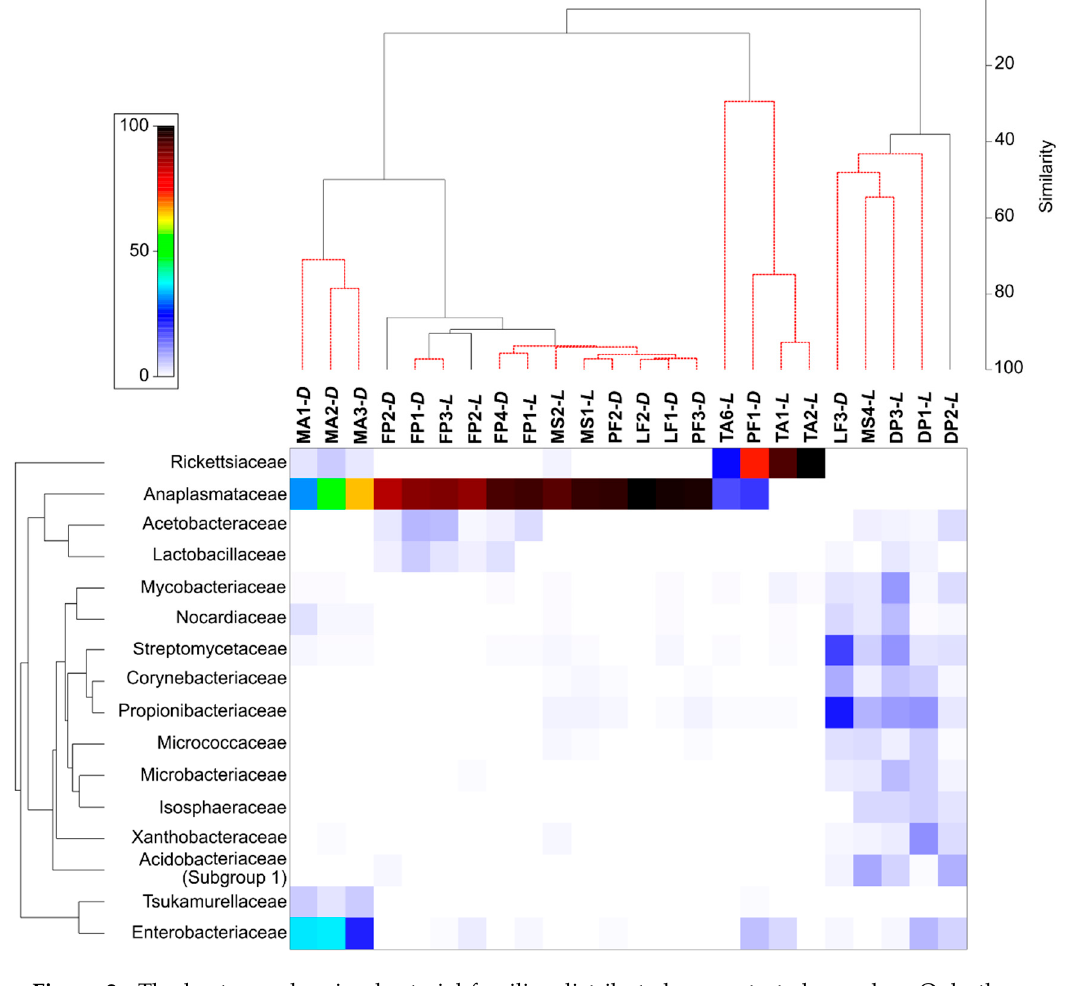
Figure 2. The heatmap showing bacterial families distributed across tested samples. Only those families who were primarily responsible for the observed differences among samples were considered. Both dendrograms were estimated with the Bray–Curtis dissimilarity index.